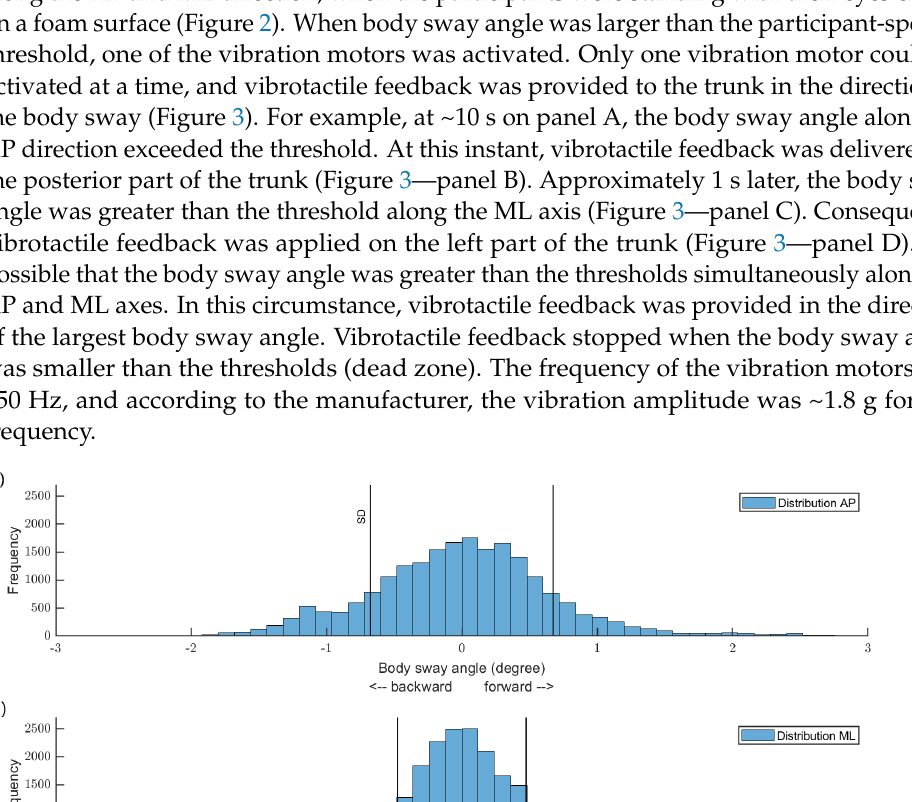
Figure 3. Examples of real-time body sway angle (blue lines, panel ( A , C )) and the thresholds (black dashed lines) for a representative participant. Panel ( A , B )) shows body sway along the AP axis and corresponding activation (1) and deactivation (0) of the vibration motors. Panel ( C , D )) shows body sway along the ML axis and corresponding activation (1) and deactivation (0) of the vibration mo- tors. The vibration motors were activated in the direction of body sway when the body sway angle was larger than the participant-specific threshold. Vibrotactile stimulation lasted for a minimum of 0.5 s. 2.3. Protocol and Experimental Conditions Before the experiment, participants were randomly assigned to either the 100% or the 33% feedback groups and completed the IPAQ — Short Form. This self-reported